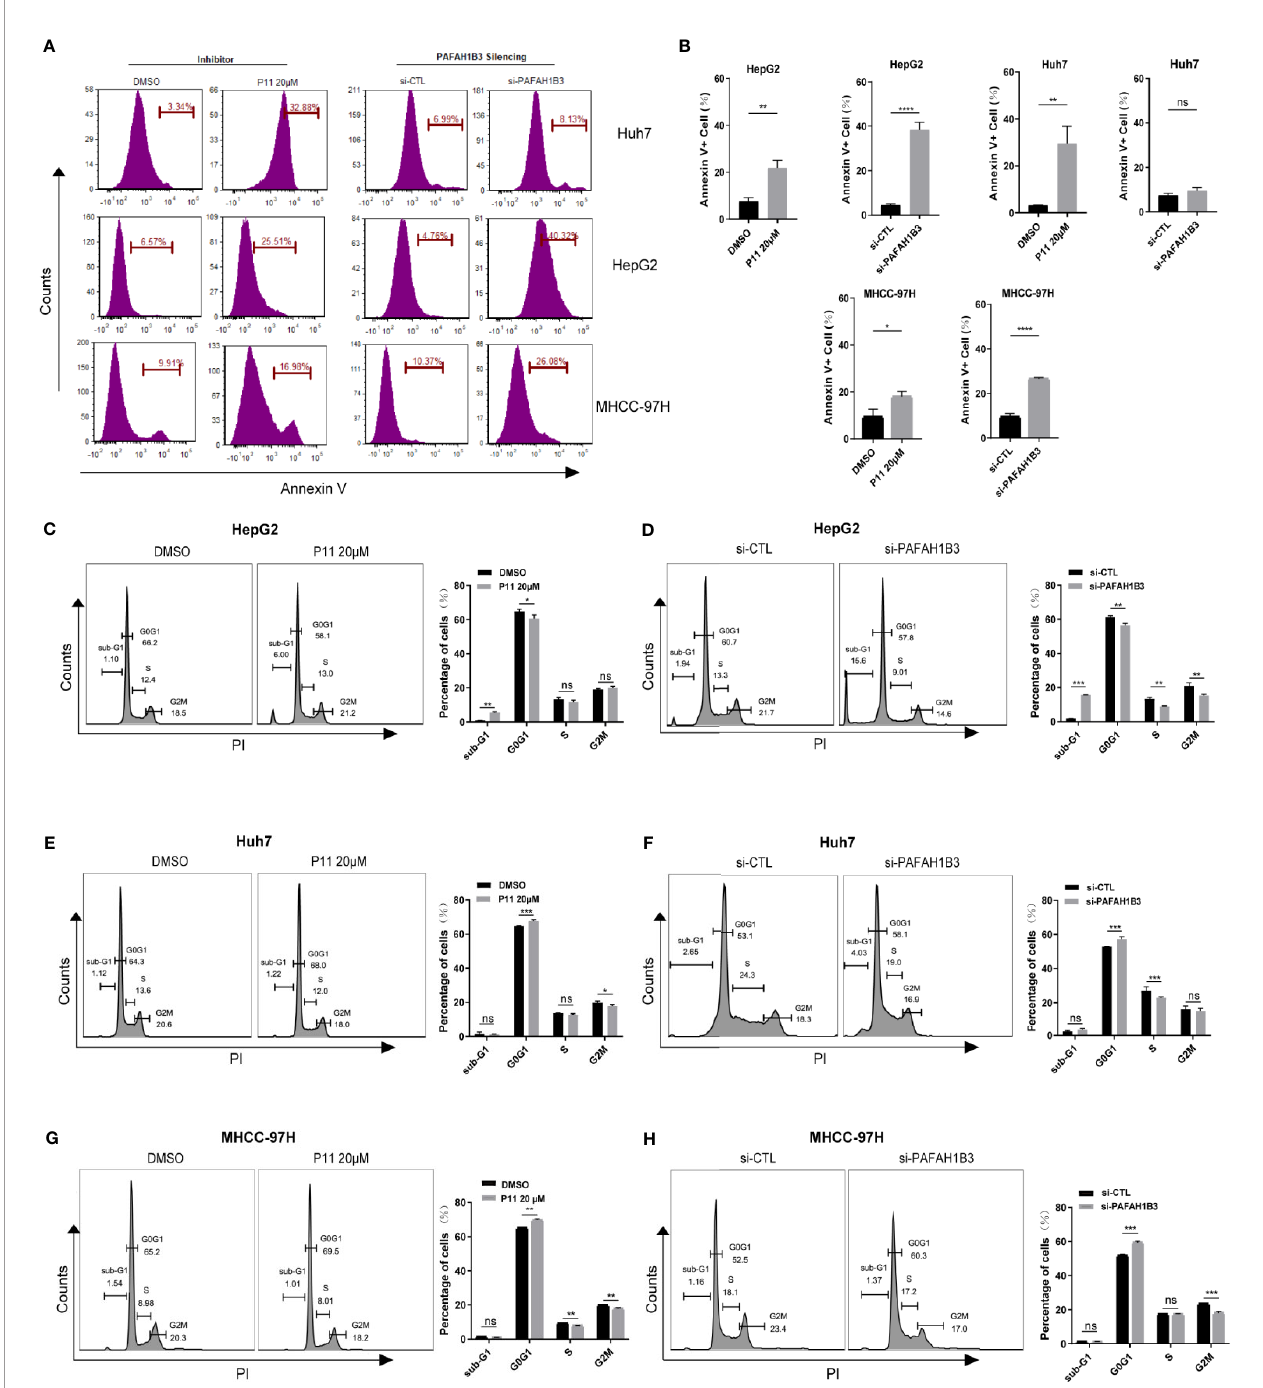
FIGURE 5 | The effects of PAFAH1B3 on HCC cell apoptosis and cell cycle. (A, B) The fl ow cytometry analysis revealed the effects of PAFAH1B3 silencing or inhibitor P11 on cell apoptosis. (C – H) Cell cycle analysis in HepG2, Huh7 and MHCC-97H cells. *p < 0.05; **p < 0.01; ***p < 0.001; ****p < 0.0001. NS, no signi fi